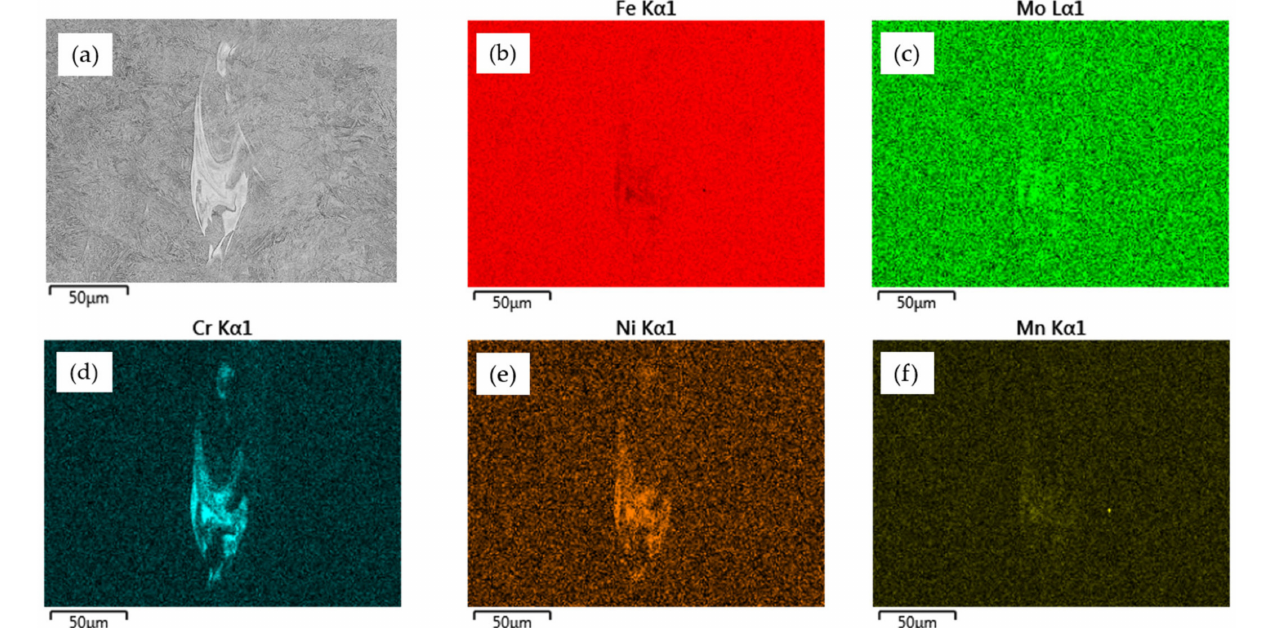
Figure 6. EDS element distribution identified in the 21NiCrMo2 steel area of structural heterogeneity: ( a ) micro-area image, ( b ) share of iron, ( c ) share of molybdenum, ( d ) share of chrome, ( e ) share of nickel, and ( f ) share of manganese.